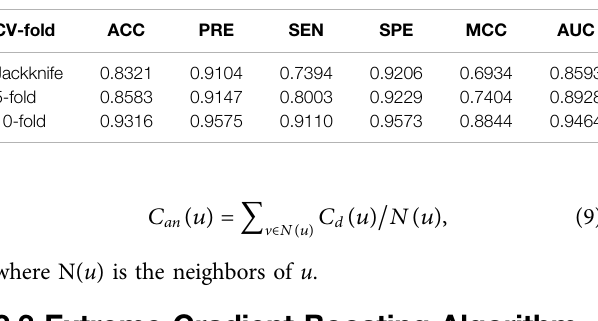
TABLE 3 | Performance obtained from different cross-validation tests based on XGBoost